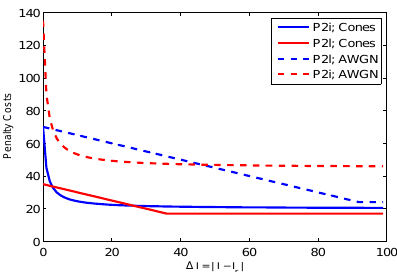
Figure 6: Optimal penalty functions ( P 2,l and P 2,i ) for the Cones image (solid lines) and in the presence of AWGN (dotted lines).